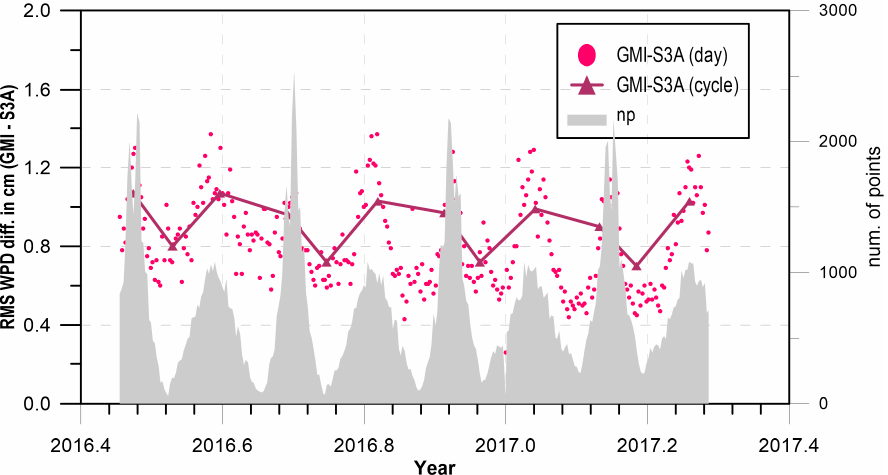
Figure 6. Time evolution of the daily RMS of the WPD differences between the GMI and S3A. The number of points is represented by “np”.